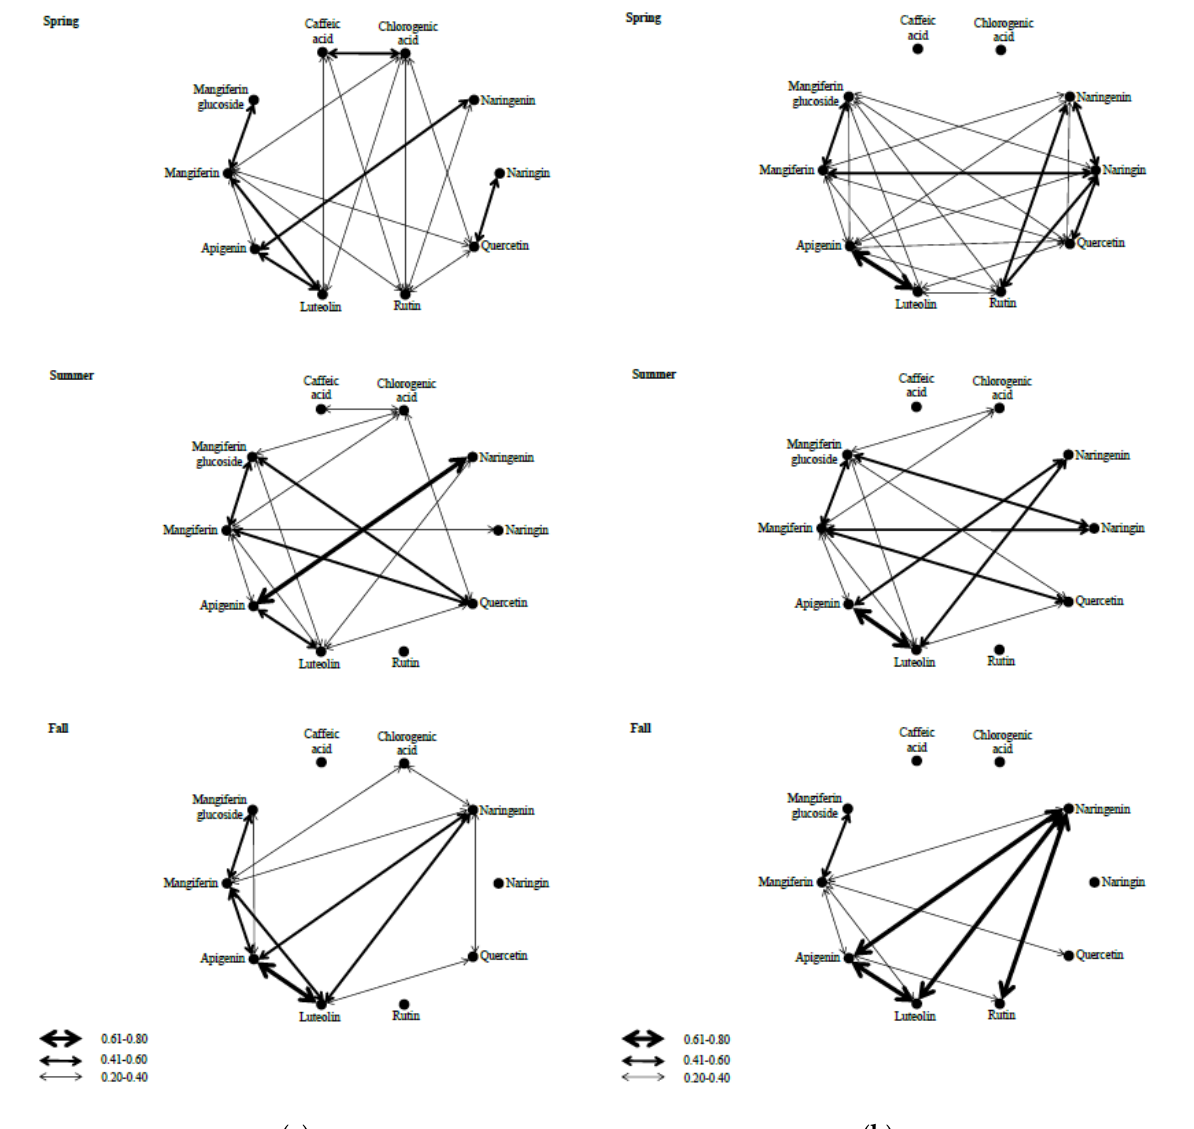
Figure 2 . Statistically significant correlations between 10 targeted metabolites quantified in I. variegata plants grown in high ( a ) and low ( b ) light treatments across three seasons of the vegetation period (spring, summer, and fall).